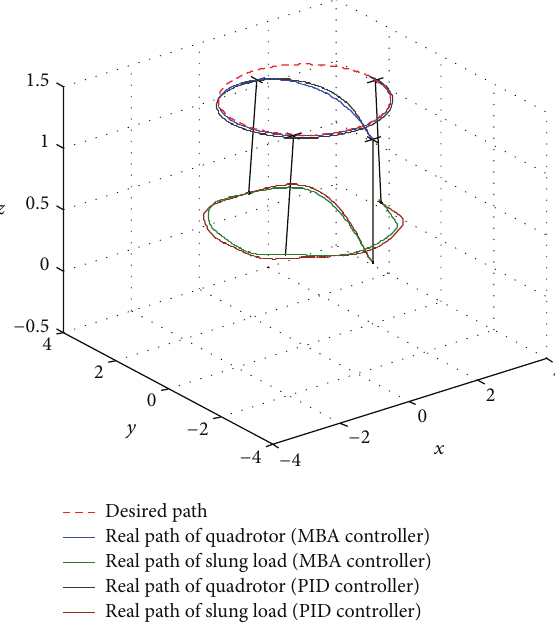
Figure 8: Altitude of quadrotor in linear flight.